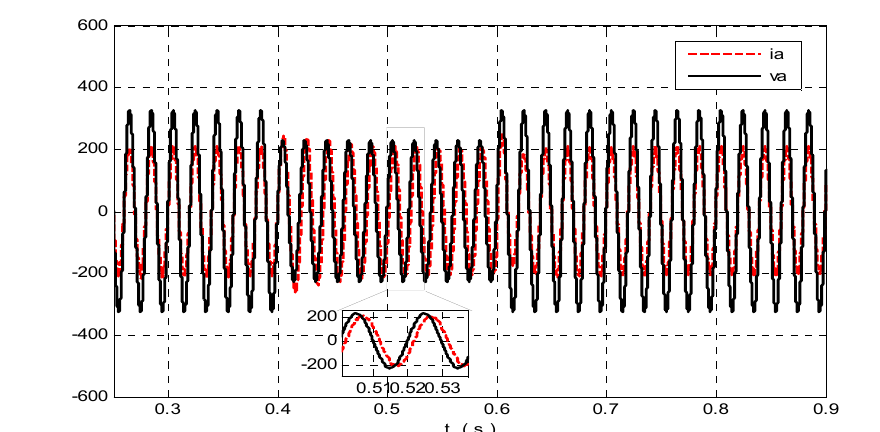
Figure 11. The grid voltages signals.